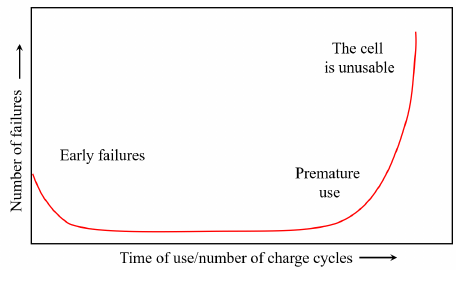
Figure 12. Charge profile.